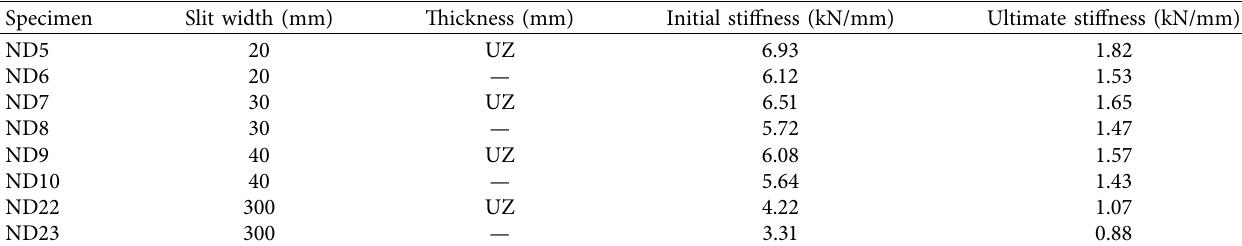
Table 12: Stiffness of different boundary